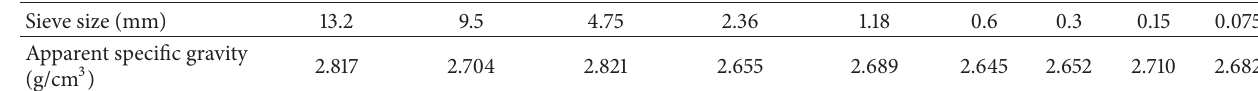
Table 4: Apparent specific gravities of